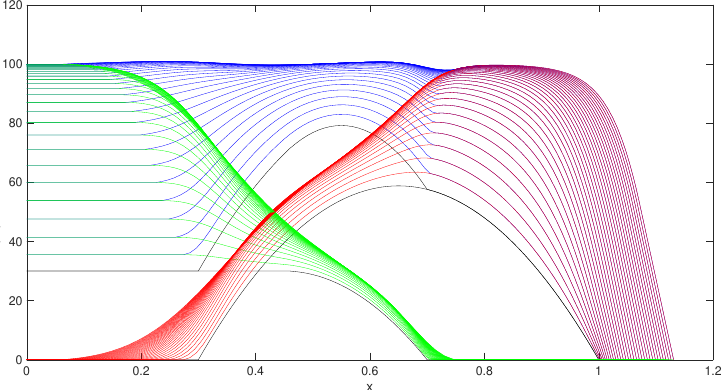
Figure 5. Result of the competition–diffusion model at t = 8. Here, we use δ 1 = 0.0001, δ 2 = 0.001, K 1 = K 2 = 1, k 1 = k 2 = 100, r 1 = r 2 = 1, and µ = 50.